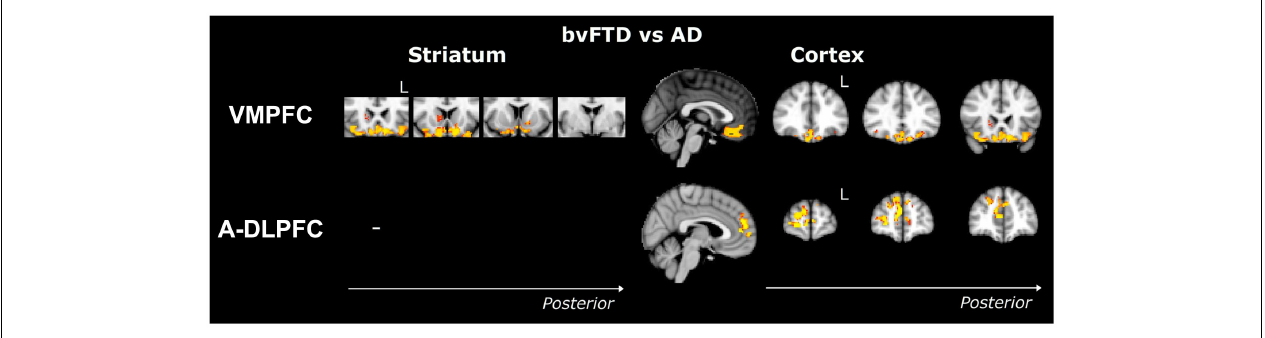
p < 0.05 corrected for multiple comparisons via Family-wise Error (FWE) and a voxel threshold of 20 contiguous voxels. Images follow radiological convention (left is right and right is left) and “L” indicates the left for coronal slices.